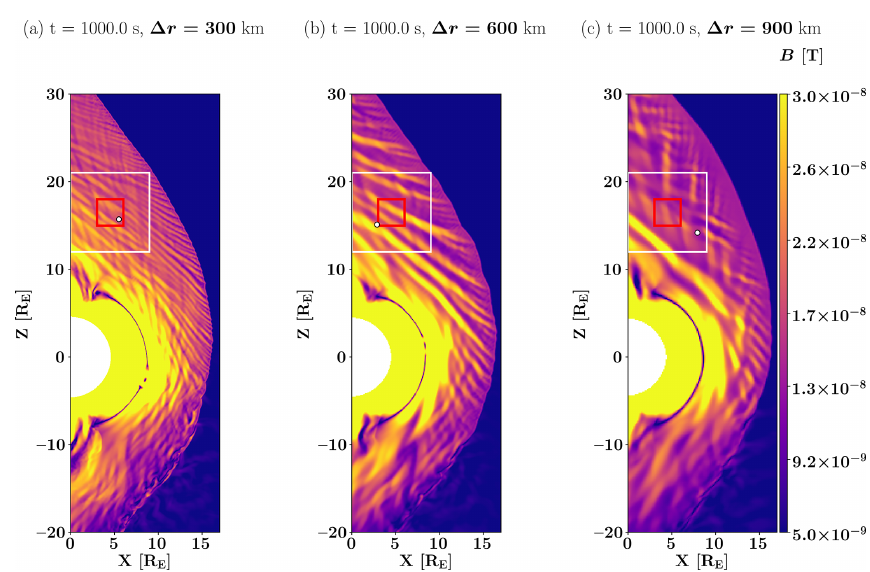
Figure 1. Global overview of the simulation set-up with three different spatial resolutions: (a) (cid:49)r = 300km, (b) (cid:49)r = 600km and (c) (cid:49)r = 900km. The colour map in each run is the magnitude of the magnetic field. The white square displays the area we focus on in the magnetosheath in the rest of the study. The red square displays the area where the FFT (fast Fourier transform) in Fig. 2 is performed. The black and white dot displays the location where data are taken for Figs. 3, 4, 5 and 6 and the VDFs in Fig.